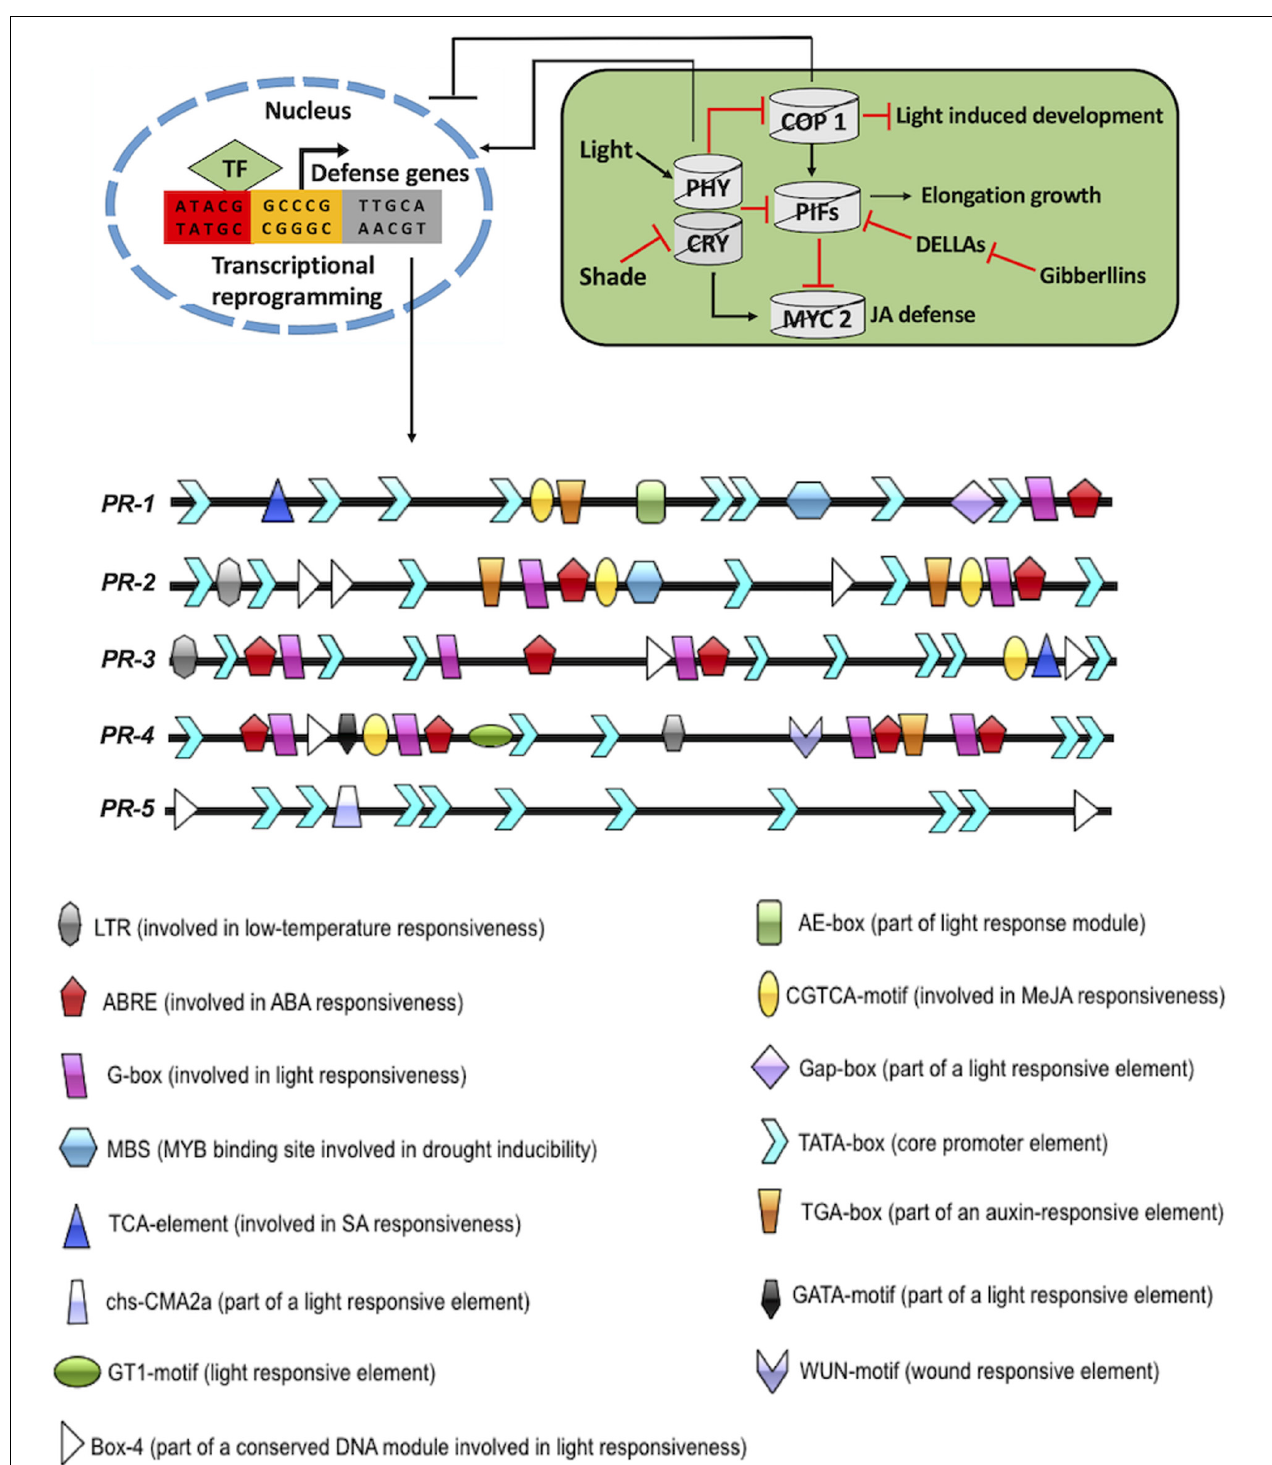
FIGURE 2 | Intersection of plant defense and light signaling. The 1,000-bp upstream sequence of PR-1 , PR-2 , PR-3 , PR-4 , and PR-5 were fetched from TAIR10 (https://www.arabidopsis.org/). The motif analysis was done by PLACE database (https://www.dna.affrc.go.jp/PLACE/?action=newplace) and PlantCARE database (http://bioinformatics.psb.ugent.be/webtools/plantcare/html/). The motif structures were drawn using Illustrator for Biological sequences software (http://ibs.biocuckoo.org/).